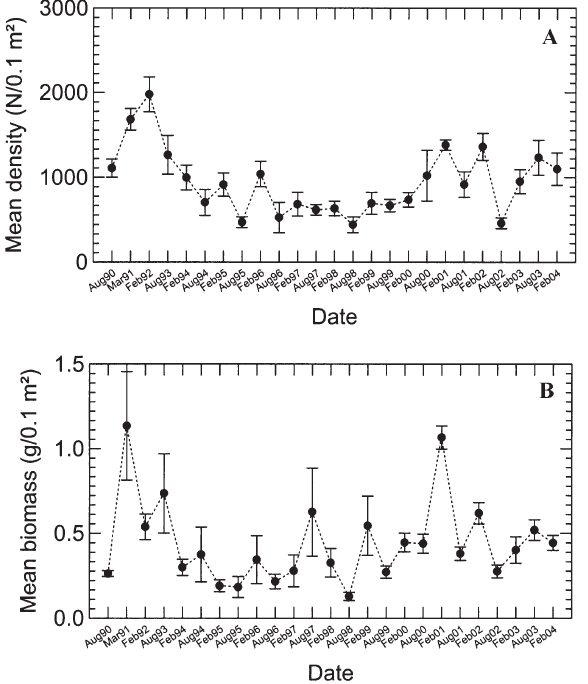
F IG . 3. – (A) Temporal fluctuations of the overall average density (N/0.1 m -2 ) and (B) biomass (AFDW g/0.1m -2 ) for the